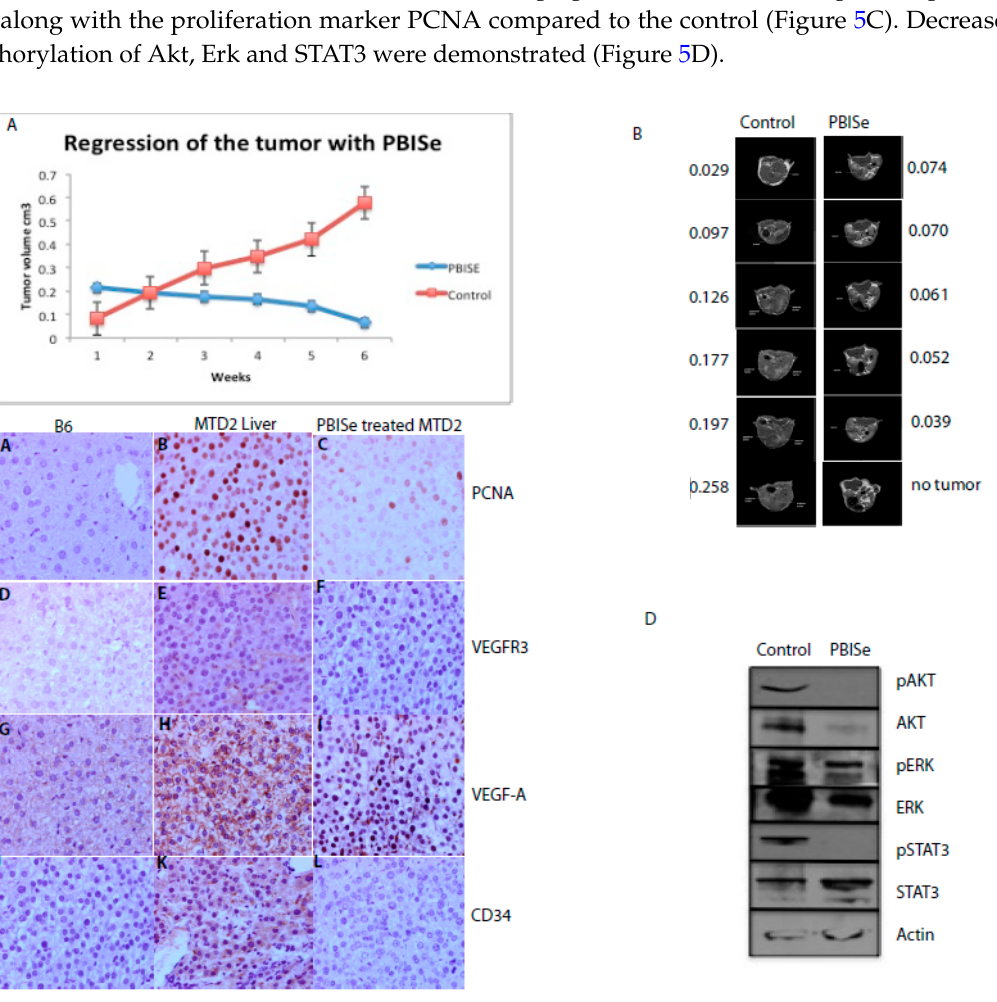
Figure 5. PBISe inhibits the growth of spontaneous murine HCC mediated by apoptosis and regulating angiogenesis. MRI was performed to confirm the initial size of the tumor prior to the start of the PBISe treatment. PBISe (2.5 ppm as se) was administered intra peritoneal (i.p.) to the HCC mice, every alternate day for about 6 weeks. ( A ) shows the regression of the tumor size ( n = 6). MRI images taken at week 1 through week 6 are shown ( B ). Role of PBISe on angiogenesis is demonstrated on the PBISe treated murine HCC by IHC. PBISe decreased VEGFR3, VEGF and CD34 ( C ). Additionally, the inhibition of pAkt, pErk and pSTAT3 is demonstrated ( D